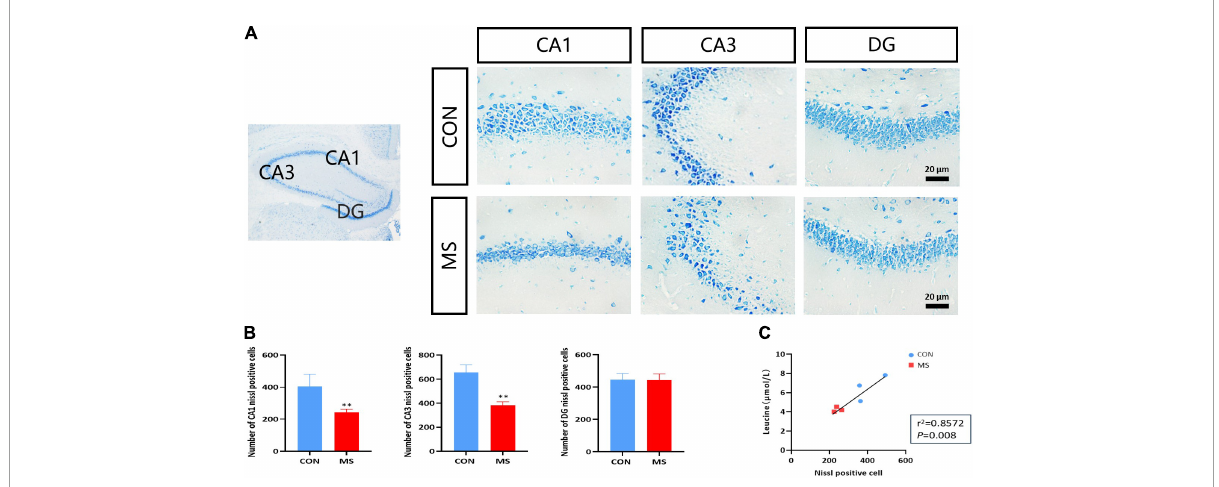
FIGURE2 Hippocampal neuronal damage is caused by MS, and the number of neurons is positively correlated with leucine content in cerebrospinal fluid. (A) Nissl staining in the hippocampus. (B) Statistics of Nissl-stained positive cells. (C) Leucine levels were highly correlated with the number of hippocampal neurons. ∗∗ p < 0.01 vs. control, n = 3.